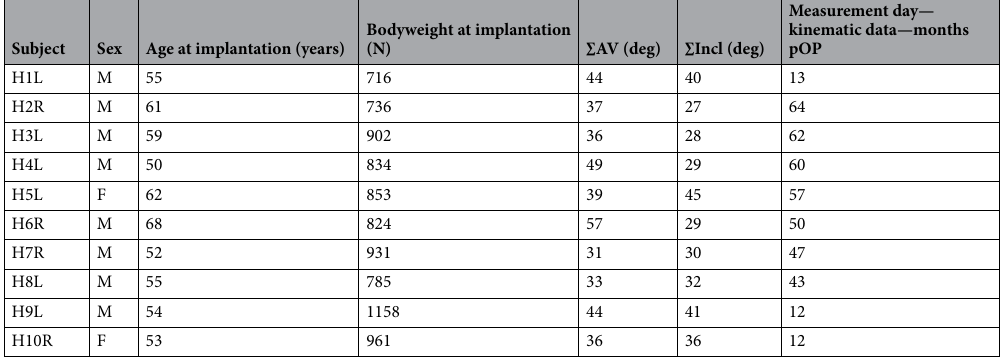
Table 1. Investigated subjects and individual implant